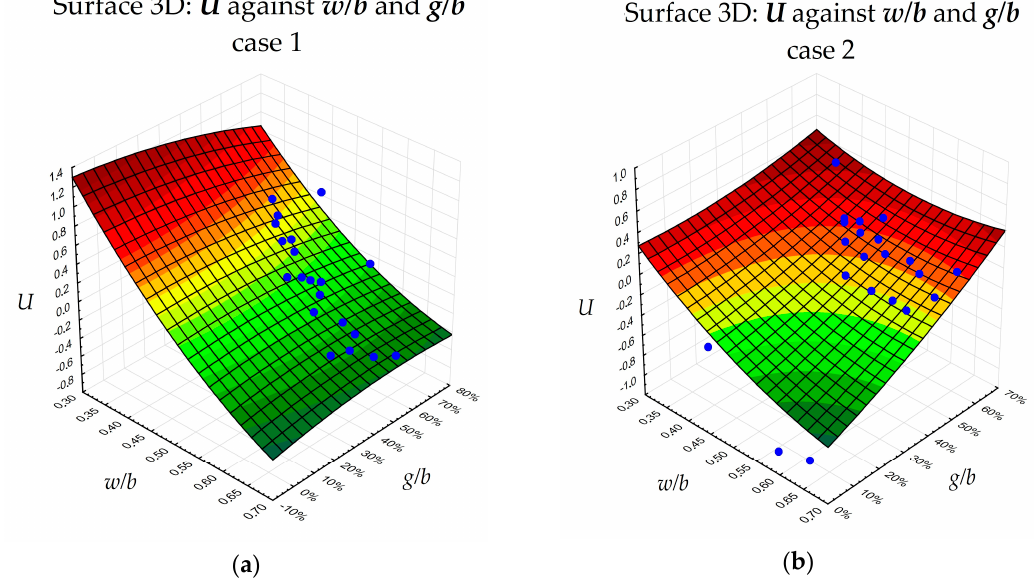
Figure 4. Utility of concrete with GGBS in function of w / b and g / b : ( a ) weight case 1; ( b ) weight case 2.